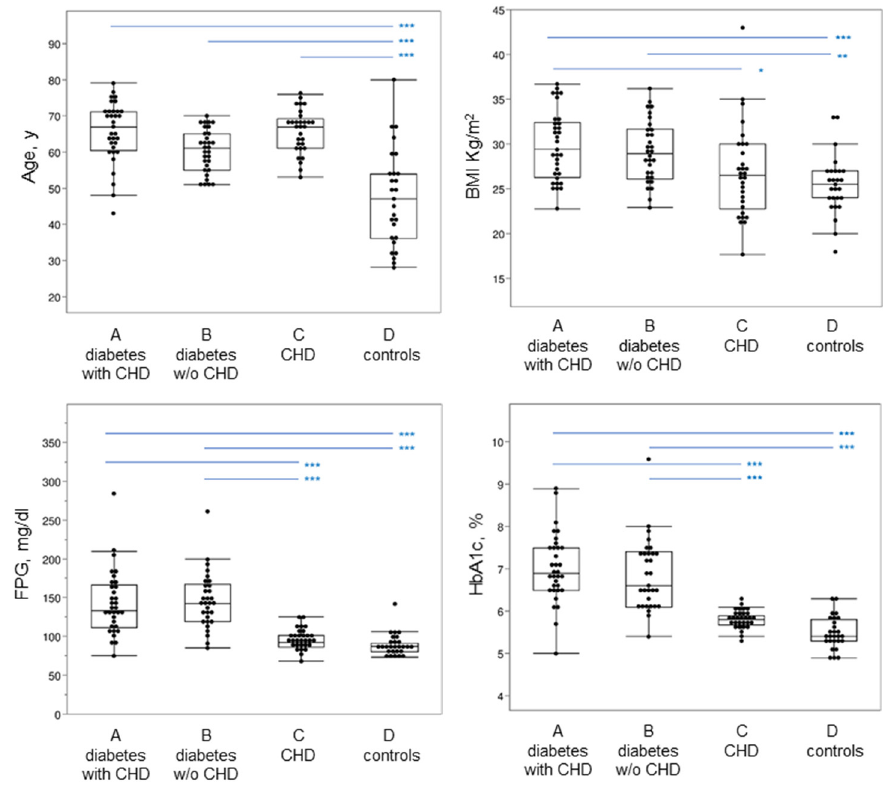
Figure 1. Clinical and metabolic data evaluated in the four groups of subjects. In the box plot, the ends of the box represent the 1st and 3rd quartile, respectively. Each box is divided by a line, which represents the median value. The whiskers show the values corresponding to [1st quartile − 1.5 × (interquartile range)], and [3rd quartile + 1.5 × (interquartile range)]. Horizontal blue lines on the top part of the graph indicate post hoc comparisons between groups by Tukey’s HSD test, following significant ANOVA. BMI, body mass index; CHD, coronary heart disease; FPG, fasting plasma glucose; HbA1c, glycated hemoglobin. *** p < 0.001; ** p < 0.01; * p < 0.05.